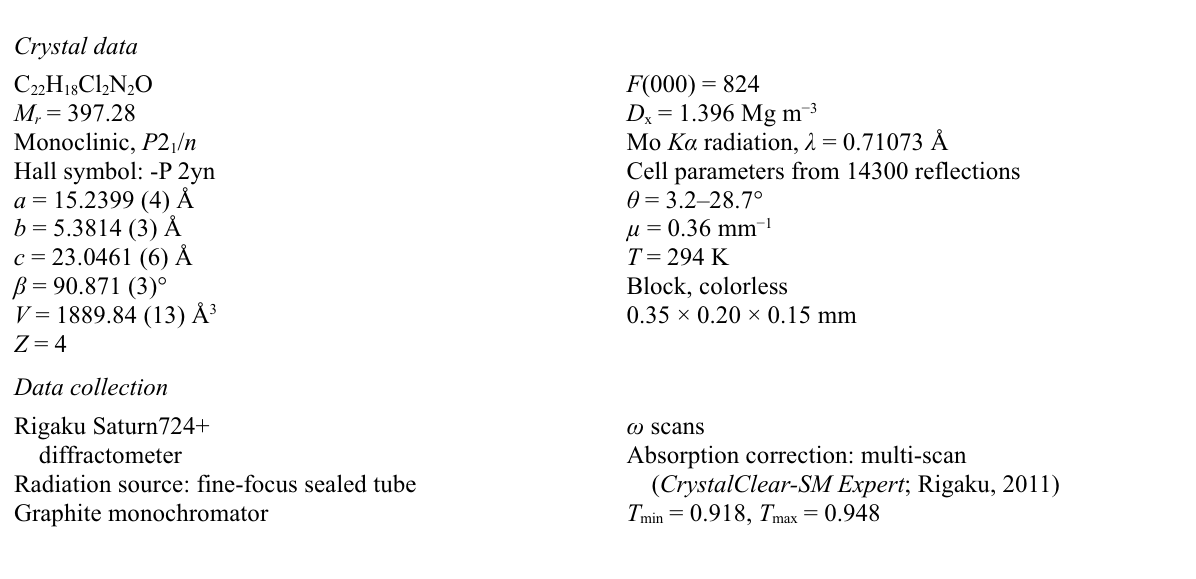
A view of the crystal packing of the title compound [H-atoms have been omitted for